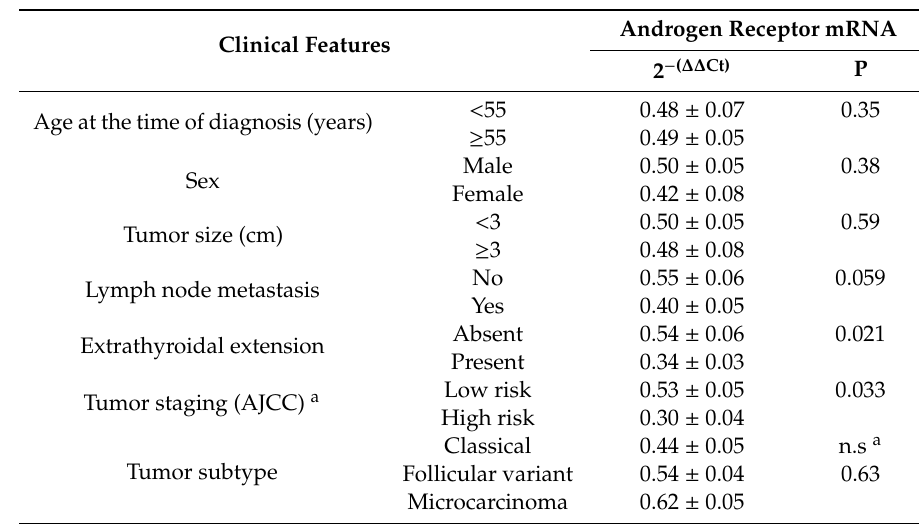
Table 2. Association of AR mRNA expression with clinical features in papillary thyroid carcinomas. ( n =